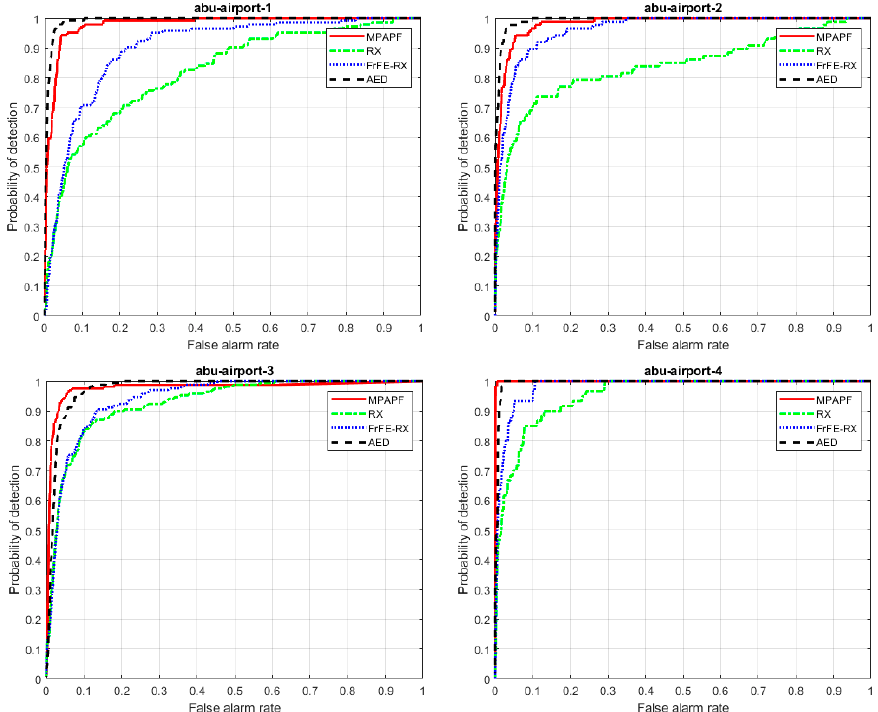
Figure 7. ROC curves of the compared methods on the ABU-Airport Scene.